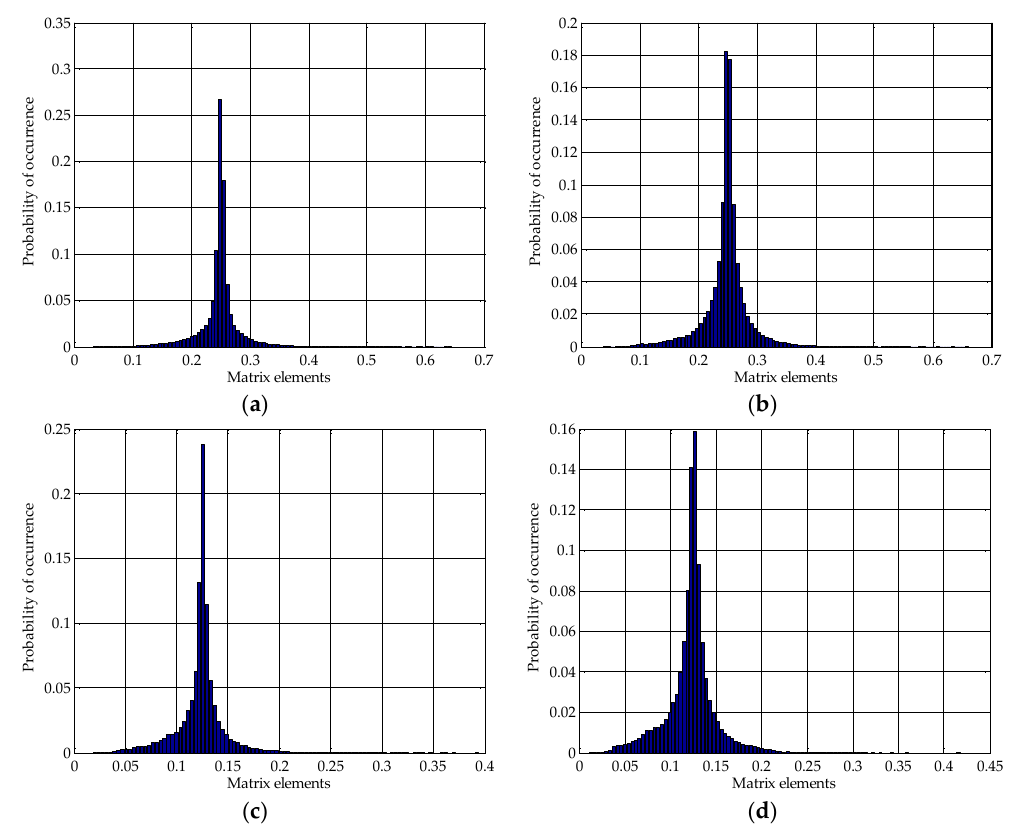
u v for block sizes 4 4  and 8 8  : ( a ) for block sizes 4 × 4 and 8 × 8: 1 1 1